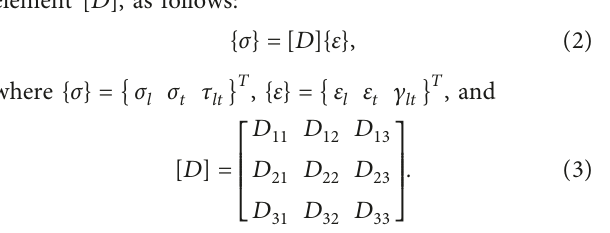
Figure 5: (a) Local stress state of a side wall element and (b) the torsional shear flow (thin-walled tube